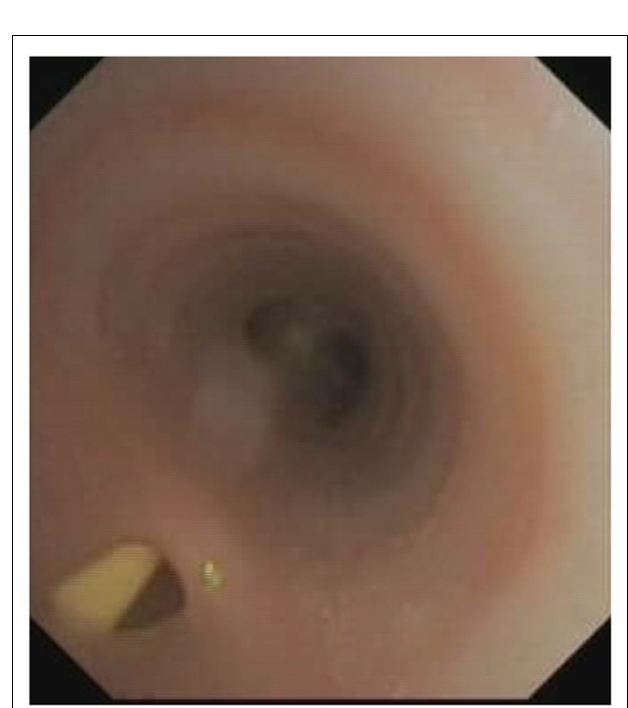
FIGURE 4 |Tracheoesophageal cleft with nasojejunal tube visible in the esophagus . Note the absence of a “fistula” or “tube connection” but a confluence of the tracheal and esophageal